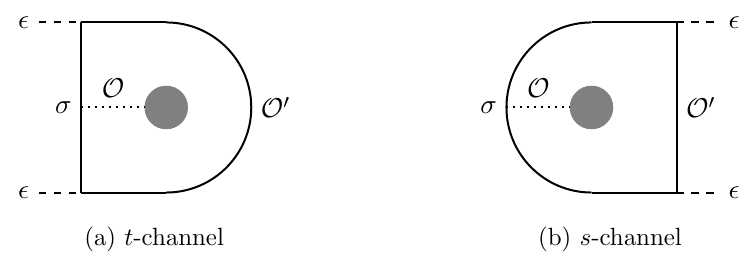
Figure 10. To obtain the [ (cid:27)(cid:27) ] thermal coe(cid:14)cients proportional to a h (cid:15)(cid:15) i must invert sums over [ OO 0 O 0 ] in the t -channel. Of course, the diagrams are crossing symmetric, so the required t -channel terms are obtained from inverting the sum over [ (cid:27)(cid:27) ] in the (cid:12)rst